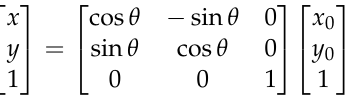
The “findContours” function in OpenCV was used to find the contour of the image, including the contour of sugarcane and the contour of holes. The function extracted the minimum circumscribed rectangle of each contour, among which the largest circumscribed rectangle was the contour of the sugarcane. The circumscribed rectangle of the contour of sugarcane is shown in Figure 4d. Considering the existence of curved sugarcane, the tilt of sugarcane can cause interference to stem node recognition. Therefore, the original image needed to be transformed and corrected. The sugarcane image was rotated at a certain angle to make the centre axis of the sugarcane parallel to the horizontal axis of the image using an affine transformation. Affine transformation only changes the position of the image relative to the coordinate system, but it does not change the relative position between pixels. The rotation function inputs the sugarcane image and the angle of rotation and outputs the rotated image [20]. The transformation equation for affine transformation is shown in Formula (1):